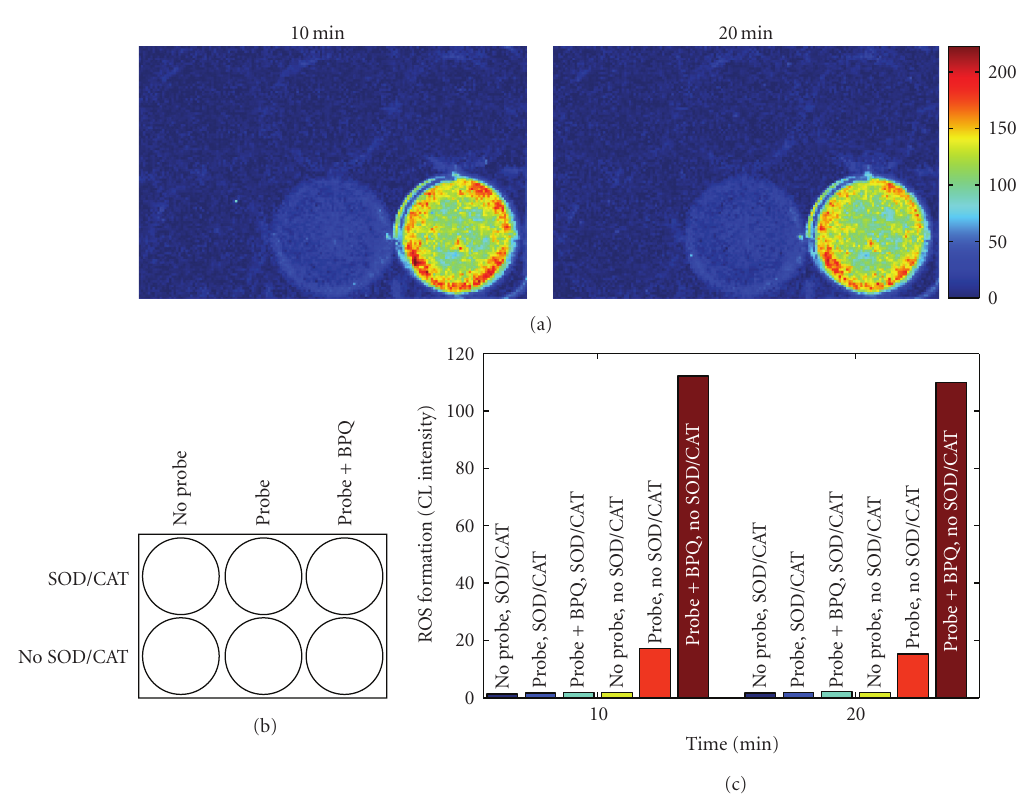
Figure 3: E ff ects of exogenously added SOD/CAT on basal and BPQ-stimulated ROS formation in cultured monolayers of H9c2 cardiomyocytes. The experimental condition was the same as that described in the legend of Figure 2 except that SOD (250units/mL) and CAT (250units/mL) were added to the top 3 wells. (c) Shows the quantitative data of the images in